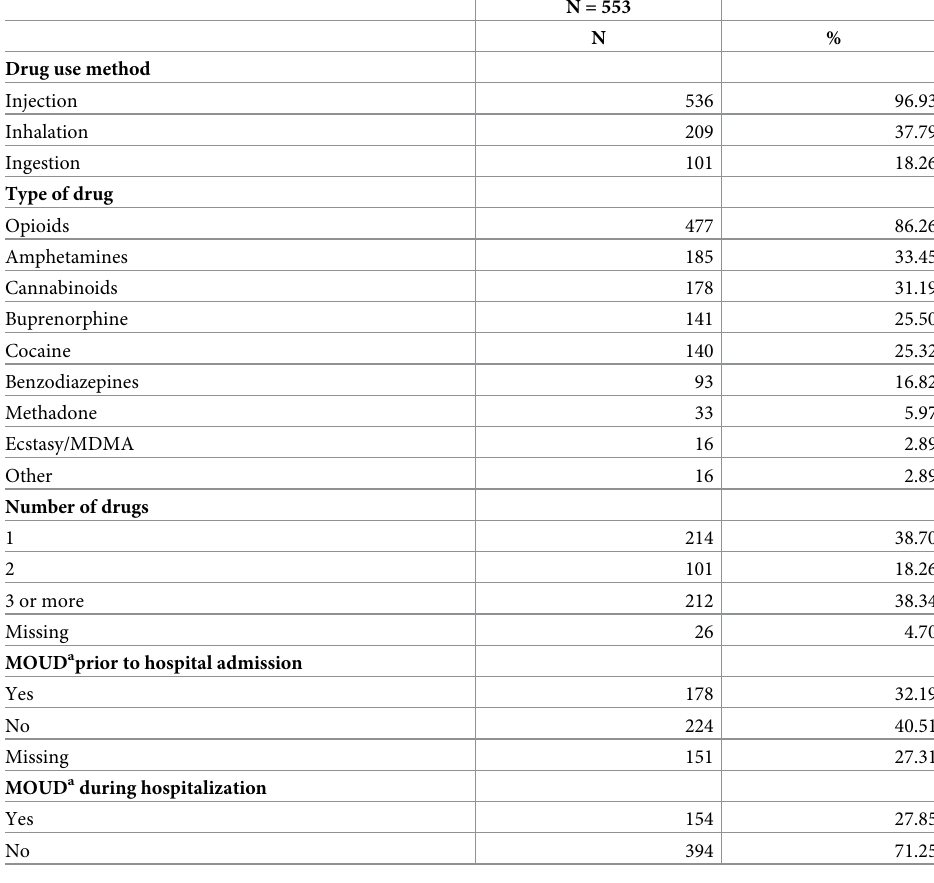
Table 3. Substance use characteristics among patients with drug-use associated infective